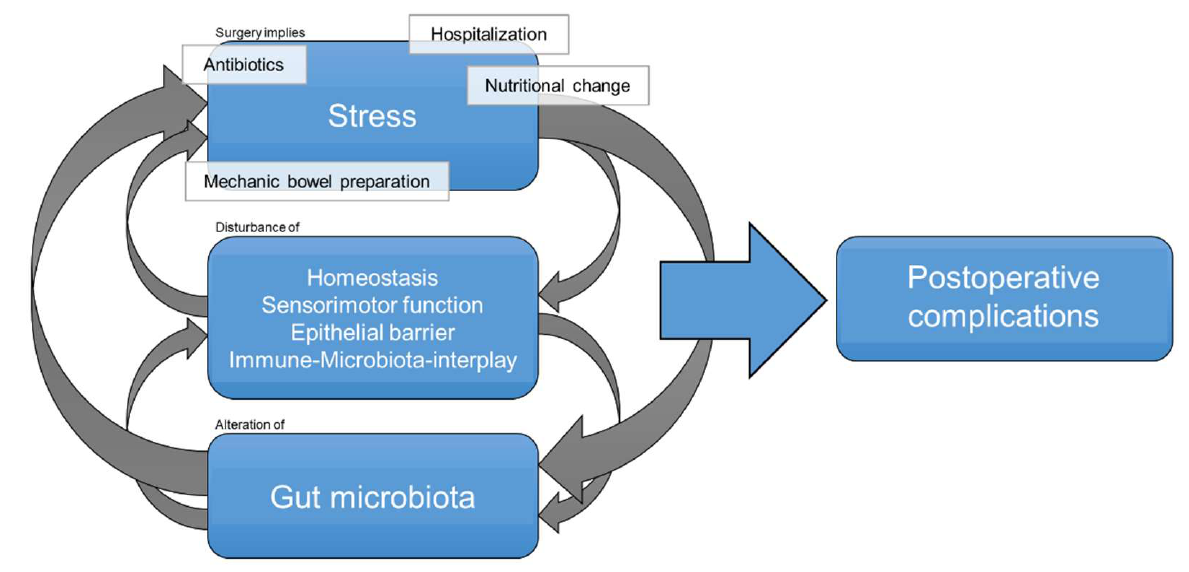
Figure 1. Overview of the relation between surgery and gut microbiota composition.